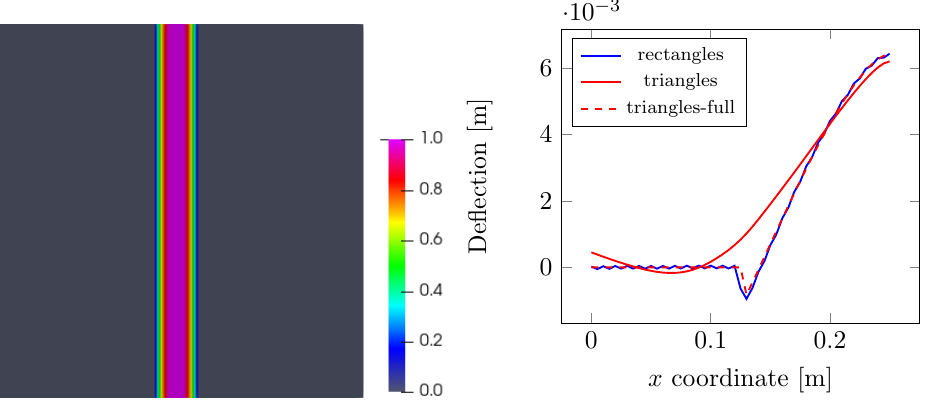
Figure 7. Initial damage distribution on quarter plate ( left ) and deflection distribution along the x -axis for triangular and quadrilateral elements and for triangular elements with assumed shear damage with ( ξ = 1) denoted as triangles-full ( right ).